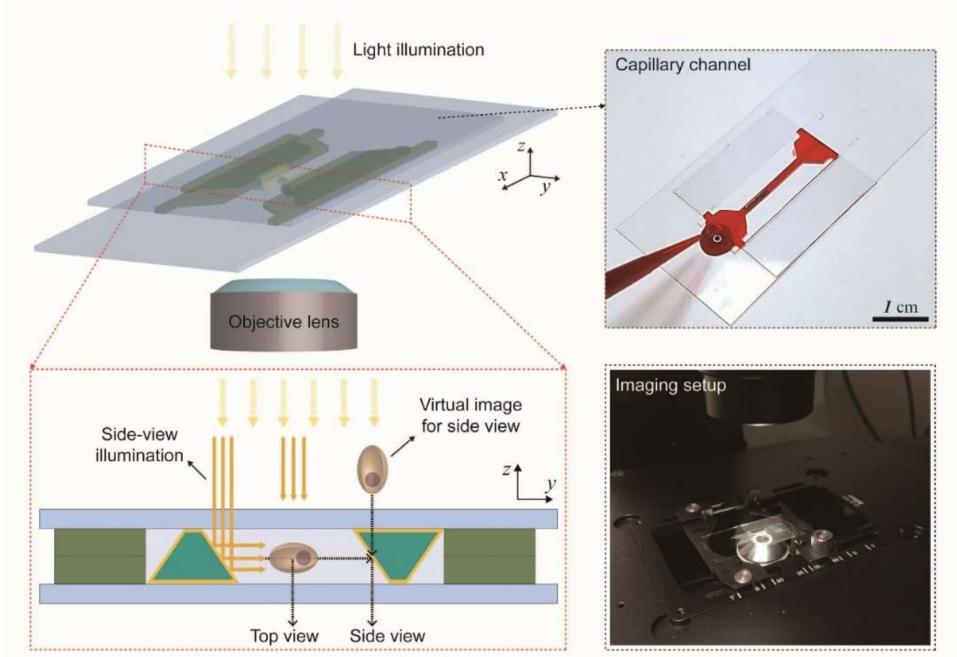
Figure 1. Schematics for bidirectional imaging with a micromirror-embedded coverslip assembly. A microfabricated capillary channel and micromirrors are integrated on coverslips to provide top-view and side-view images of a sample at the same time with a conventional microscope